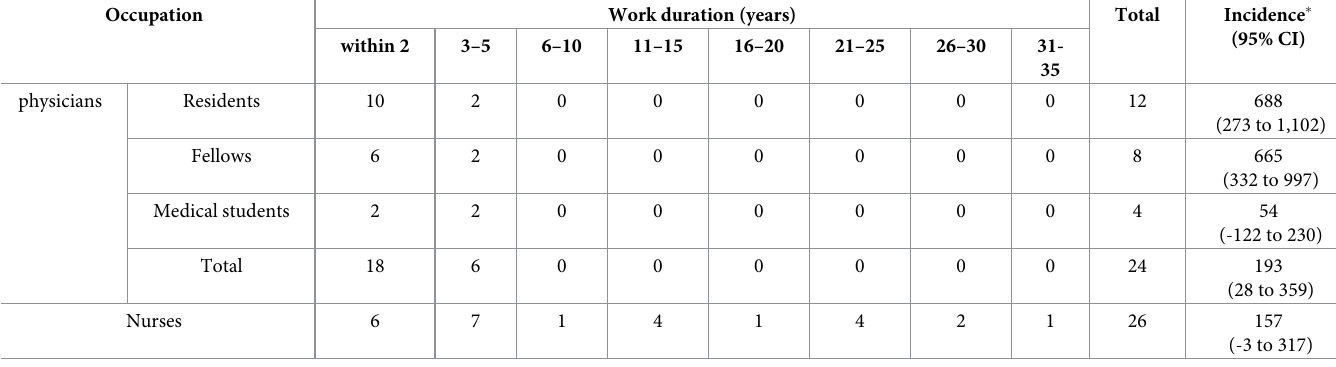
Table 4. Sub-group analysis of duration of work and profession of HCWs with TB disease at KCMH from 2012–2020.